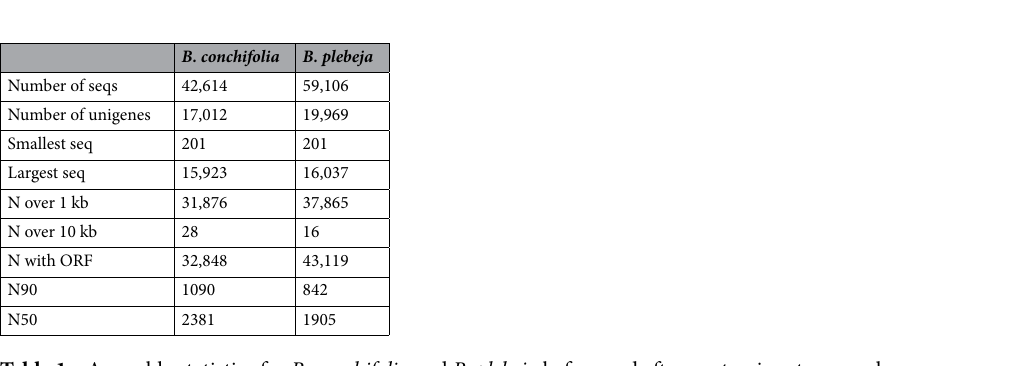
Table 1. Assembly statistics for B. conchifolia and B. plebeja before and after contaminant removal.